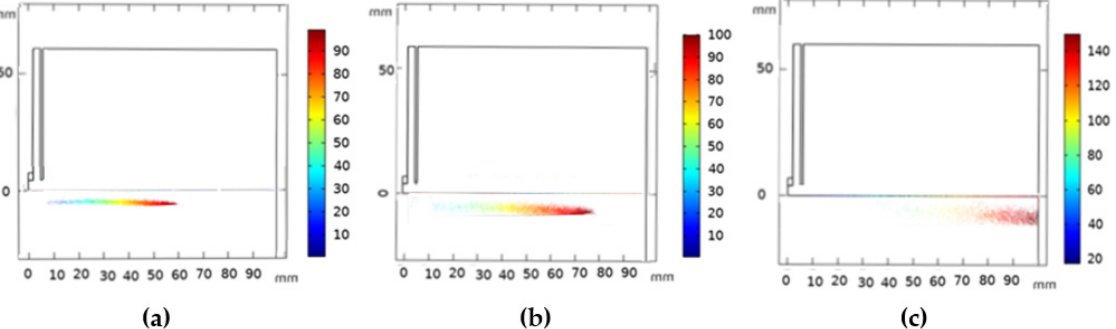
Figure 10. Predicted particles distributions at different instants (t) under the plasma jet. (t = 1.5 ms ( a ), t = 2 ms ( b ), t = 3 ms ( c ))